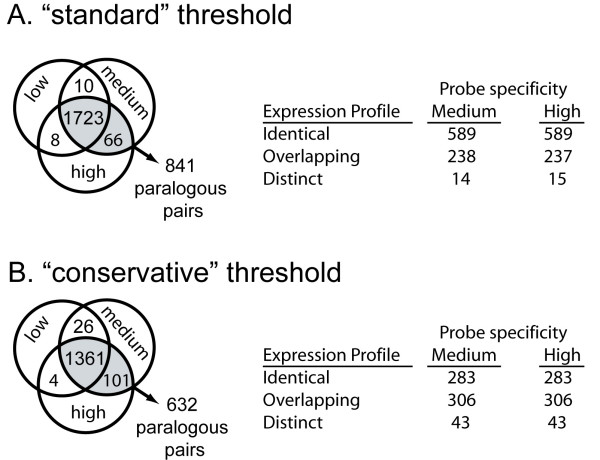
Expression of both paralogs is generally detected in the same treatments, irrespective of the probe specificity (the degree to which each probe matches one but not the other paralog) or the detection threshold (the minimum raw intensity scored as expressed). These data are based on (A) "Standard" and (B) "Conservative" threshold levels for detection of expression and three probe specificities were compared that are labeled low, medium, and high (see Methods). We report paralogous profiles whose presence/absence scores in all five treatments were identical in the medium and high specificity analysis (shaded in gray on the left of each chart). 1789 and 1462 genes had consistent present/absent expression profiles in the medium and high specificity analyses using the standard and conservative thresholds. These sets of genes included 841 and 632 paralogous pairs, respectively. The tables on the right compare paralogous profiles by tabulating whether they are both present and absent in the same treatments (identical), the expression profile of one overlaps entirely with the other (overlap), or paralogs in which each duplicate has a unique component (distinct).